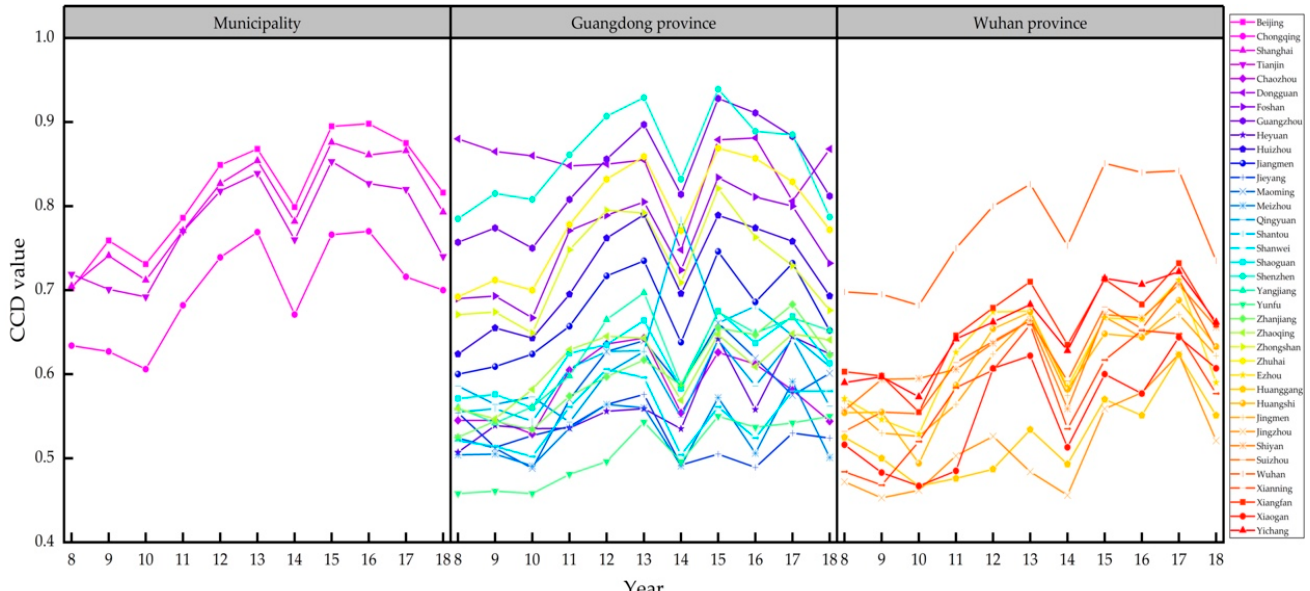
Figure 1. Changes in coupling coordination degree (CCD) value for the cities over the period Table 2. Descriptive CCD statistics 2008–2018.